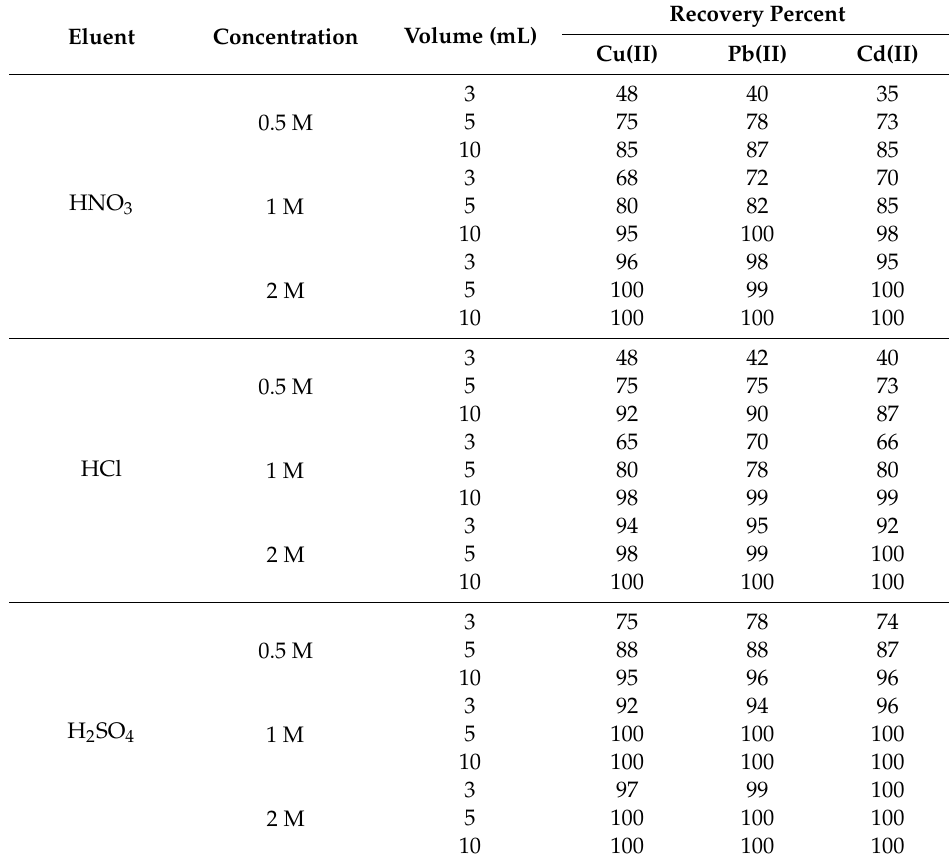
Table 3. E ff ect of stripping agent on the elution of sorbed metal ions (experimental conditions: